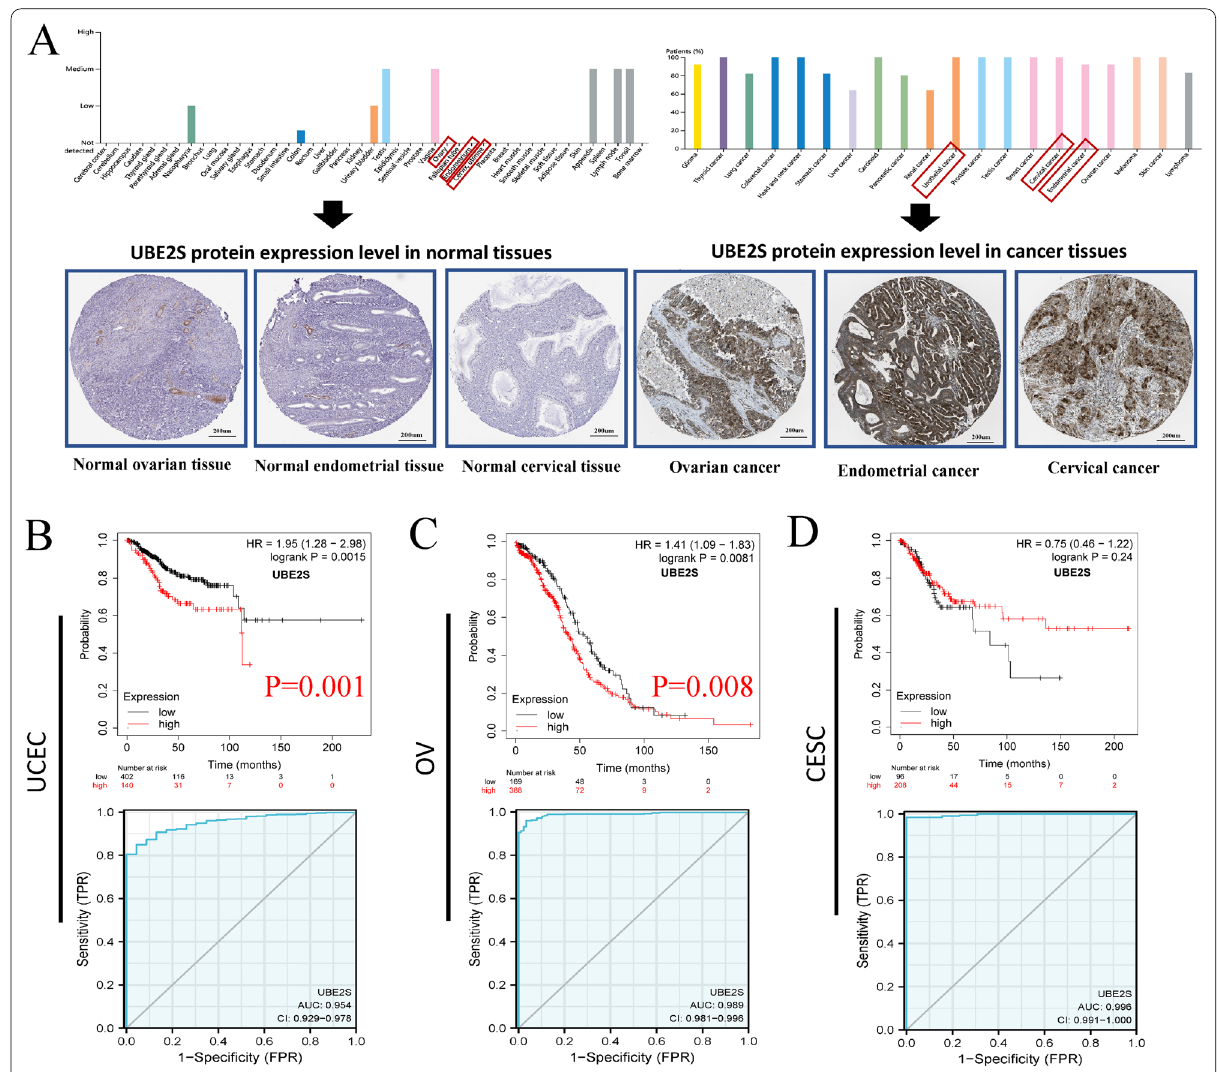
Fig. 2 UBE2S protein expression and prognosis analysis in major gynecological cancer tissues. A Immunohistochemical staining. The staining intensity represents the protein expression level of UBE2S in 45 types of normal organs and 20 types of cancer tissues in the HPA database. UBE2S was low expressed in normal ovarian tissue, cervical tissue and endometrial tissue. UBE2S was overexpressed in ovarian cancer tissues, cervical cancer tissues and endometrial cancer tissues. B–D Survival curve and ROC curve of UBE2S high/low expression group in UCEC, OV and CESC. UCEC (HR 1.95, P 0.0015, AUC 0.954), OV (HR 1.41, P 0.0081, AUC 0.989) and CESC (HR 0.75, P 0.24, AUC = = = = = =